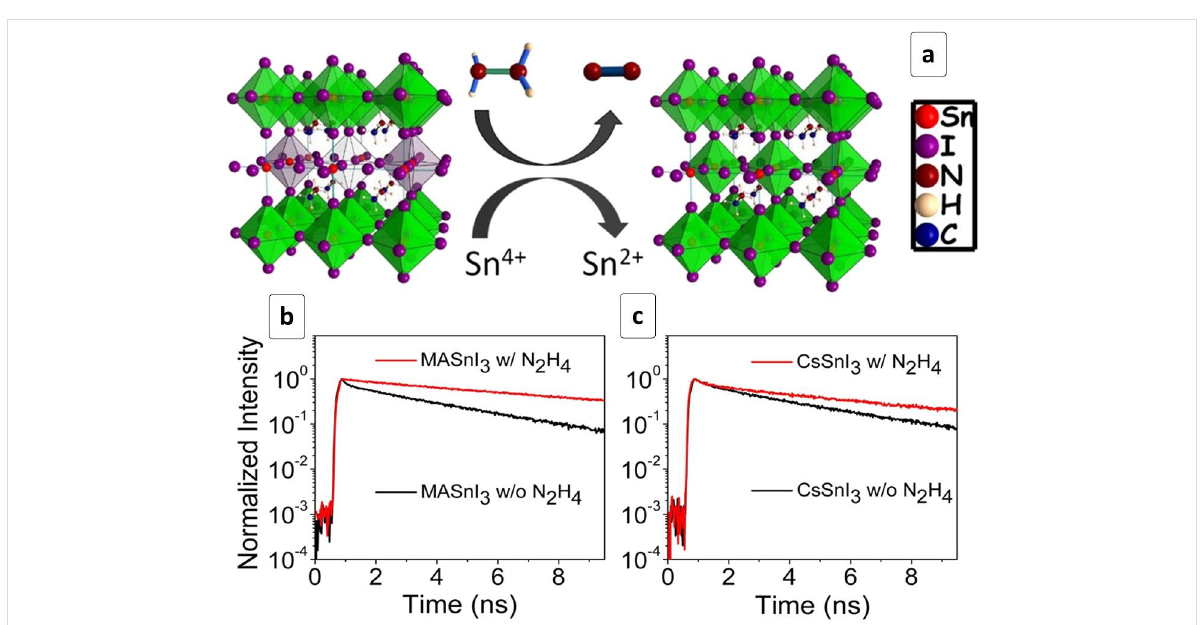
Figure 5: (a) Scheme of a possible mechanism of Sn-based HP transformation upon reaction with hydrazine; (b,c) kinetic photoluminescence decay curves for MASnI 3 (b) and CsSnI 3 (c) produced without treatment (black lines) and with an N 2 H 4 vapor treatment (red lines). Reprinted and adapted with permission from [119], copyright, 2016 American Chemical